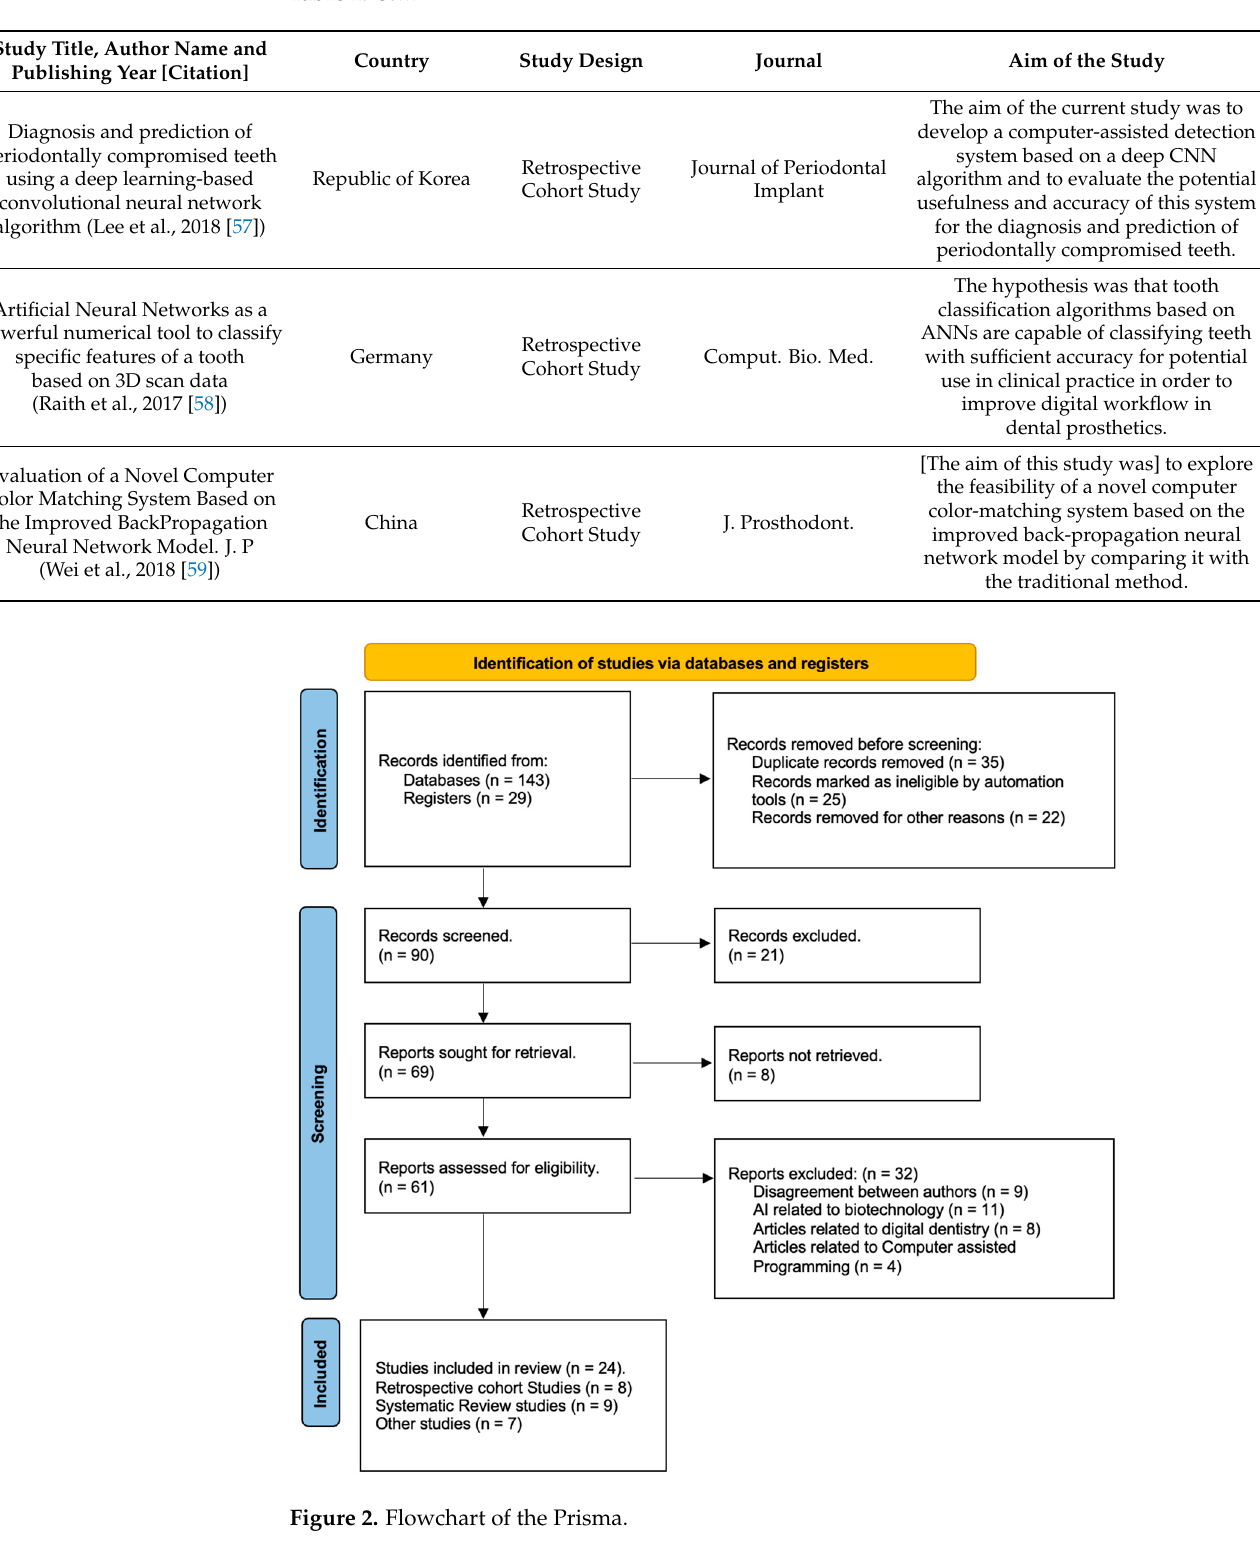
Table 1. Description of the study characteristic.